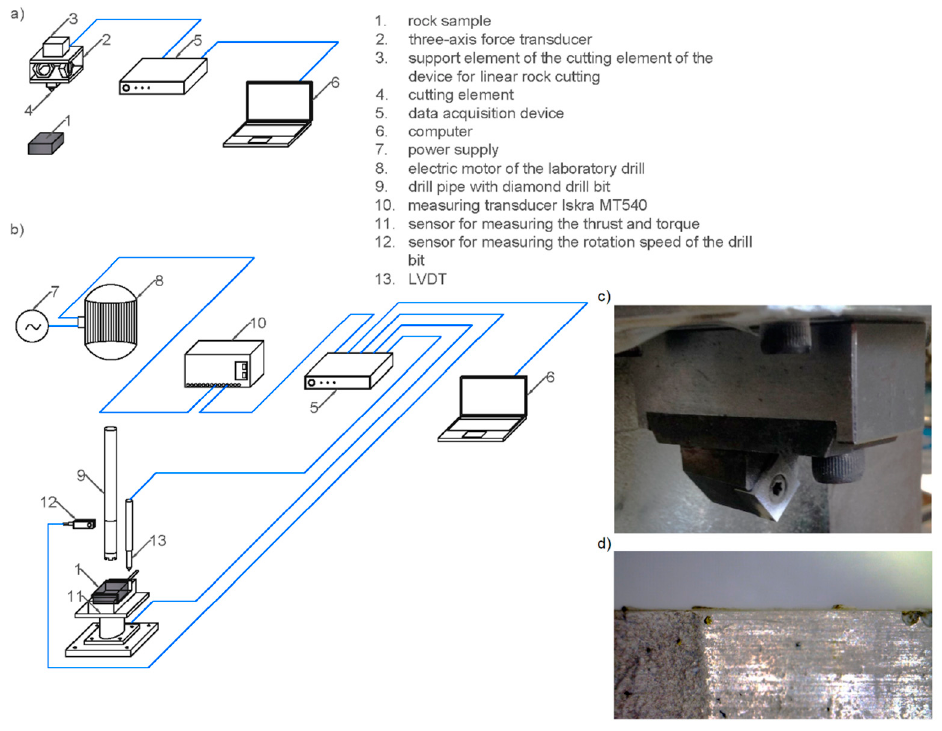
Figure 2. ( a ) Electrical power measuring system; ( b ) Measuring system with a force transducer